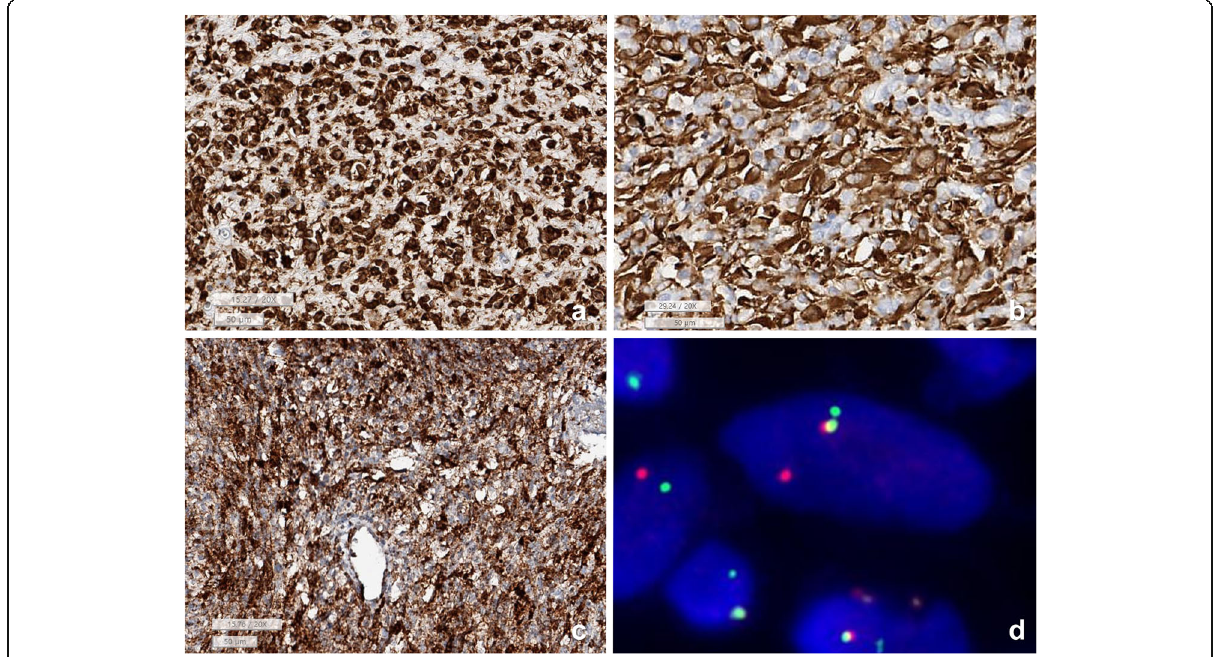
Fig. 5 Trk immunohistochemistry shows a Nuclear positivity in TPR-NTRK1 fusion sarcoma (Case 1), b mostly nuclear membrane, and cytoplasmic stain in LMNA-NTRK1 fusion sarcoma (Case 2). and c mainly cytoplasmic stain in ETV6-NTRK3 fusion sarcoma. In Fig. b , the Trk-negative cells are infiltrating inflammatory cells ( a-c : Trk IHC, lower bar: 50 μ m). d . locus-specific identifier (LSI) FISH study using ETV6 fluorescence dual-color break apart DNA probes show one fused and one widely separated SpectrumGreen and SpectrumOrange signals in an infantile fibrosarcoma with ETV6-NTRK3 (Supplementary Fig. 1-4). Split reads are the read frag- ments of the unmatched paired-end alignments. A dis- cordant alignment happens when both mates align uniquely, but does not satisfy the paired-end constraints.